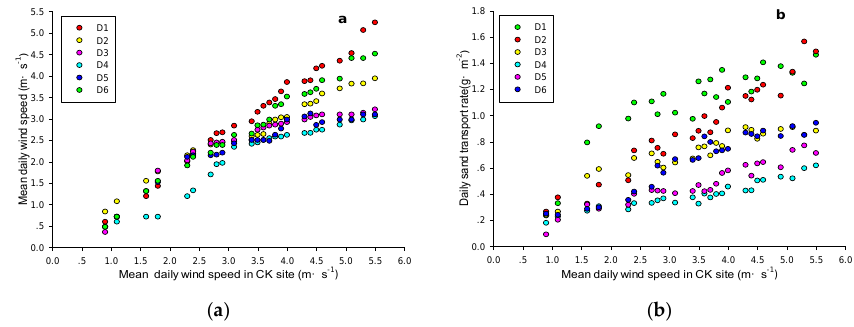
Figure 5. Relationships between poplar density and mean daily wind speed and daily sand transport rate: ( a ) relationship between mean daily wind speed at 2-m height in the six experiment sites with different densities and mean daily wind speed at 2-m height in the control site; ( b ) relationship between mean daily sand transport rate in the experiment sites with different densities and mean daily wind speed at 2-m height in the control site.